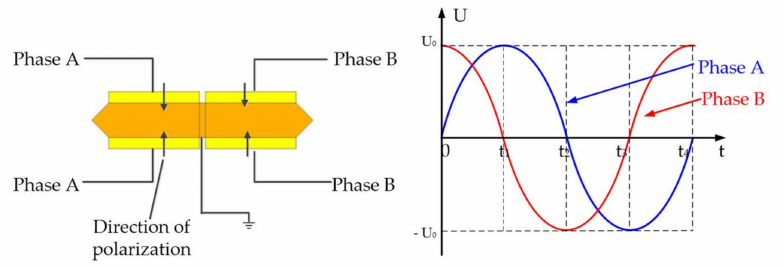
Figure 3. Polarization and excitation signals of the stator.